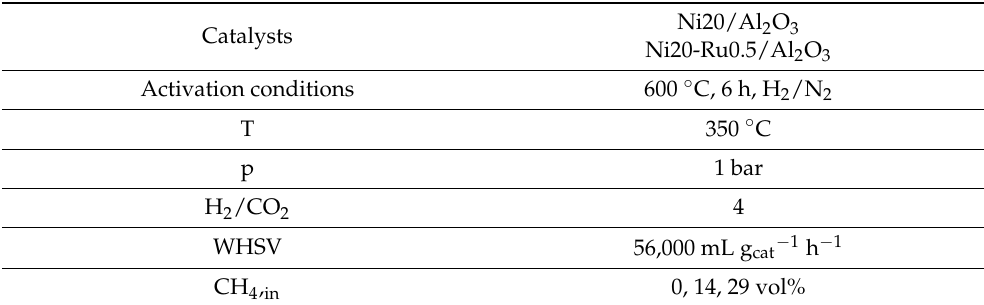
Table 5. Catalysts and reaction conditions for experiments on CH 4 influence on methanation over Ni/Al 2 O 3 with Ru promoter